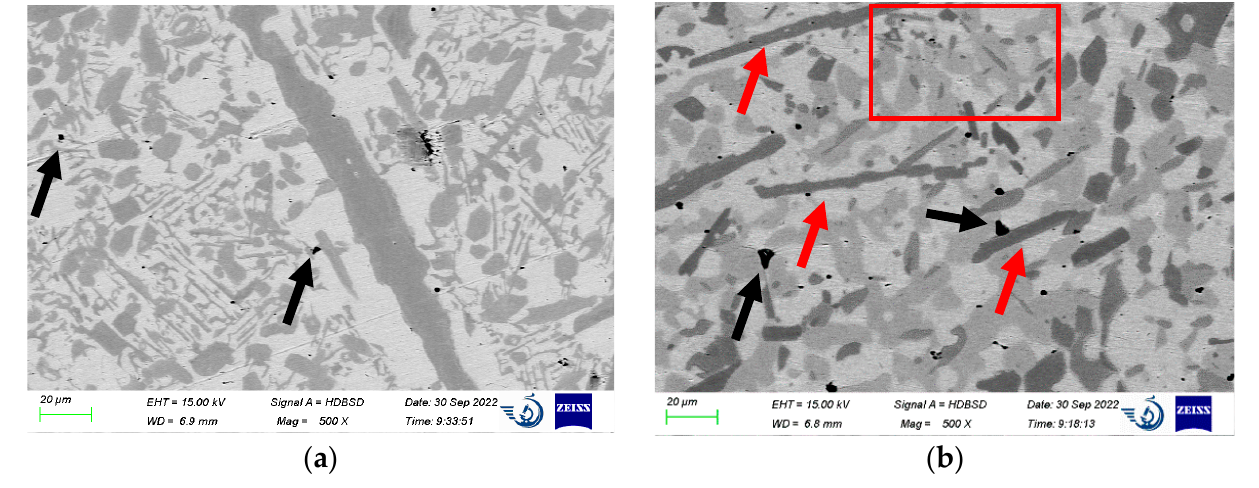
Figure 2. Microstructures of water-cooled ( a ) and furnace-cooled ( b ) samples.